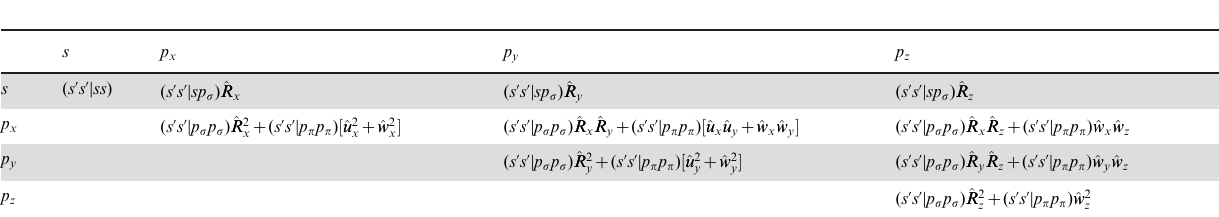
Table 1. Ideal integrals rotated onto the molecular